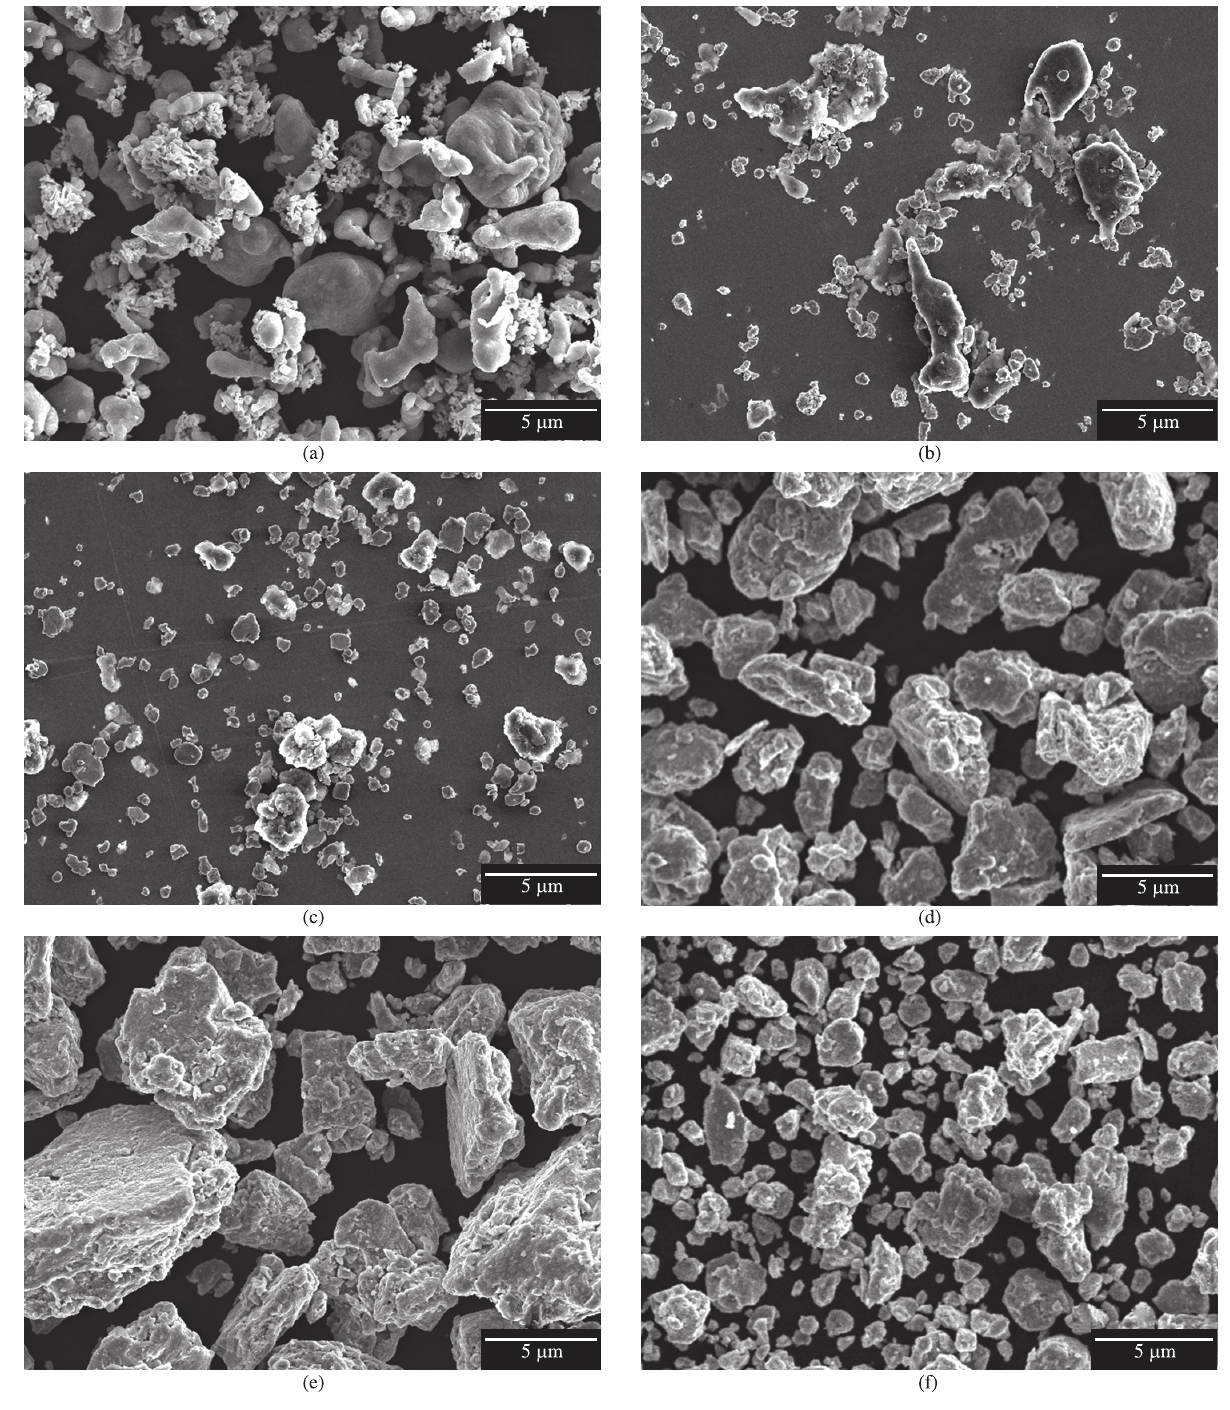
Figure 2. Morphology of Al-Mo powder mixture vs. milling time. Scanning electron micrographs, secondary electron images. Milling time: (a) 0 hours, (b)1 hour, (c) 10 hours, (d) 40 hours, (e) 70 hours, (f) 100